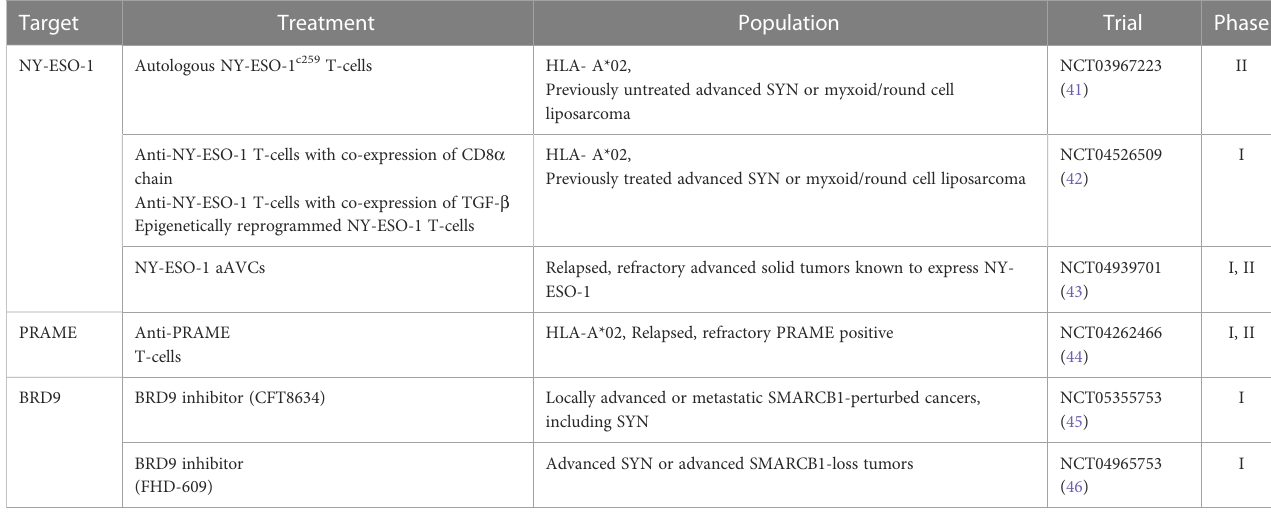
TABLE 2 Clinical trials in recruitment for treatment of